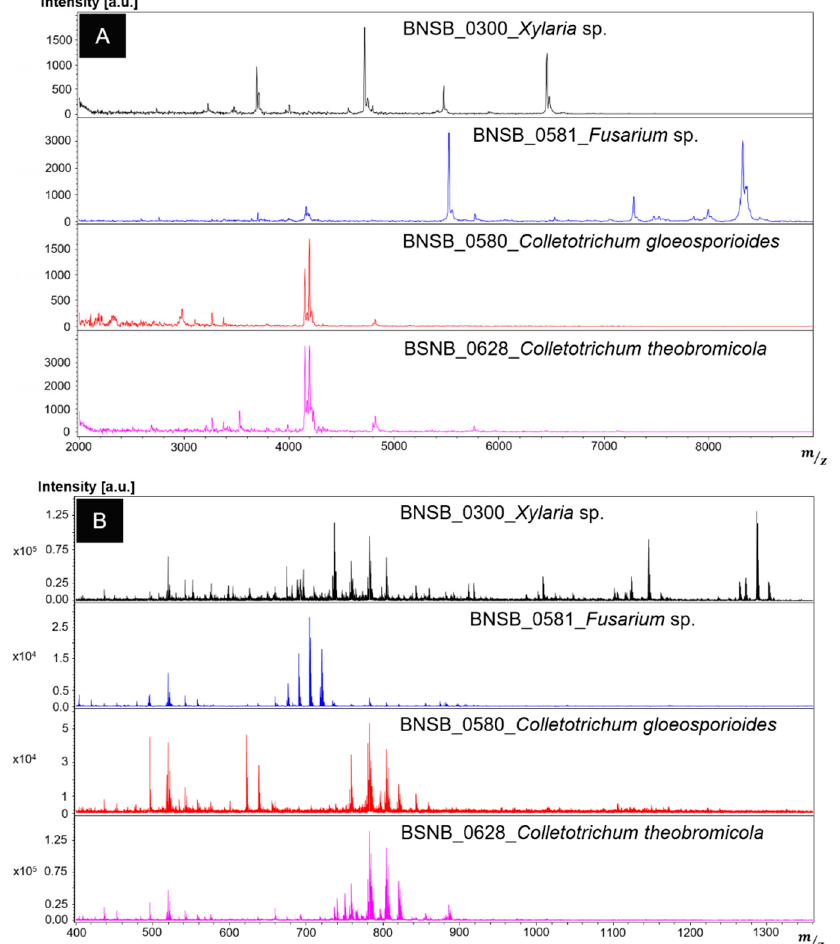
Figure 1. Examples of fungal protein fingerprints ( A ) and fungal lipid fingerprints ( B ) from BNSB. This method led to the data aggregation into twelve clusters (Figure 2). First clusters, named A and B, are composed of Enterobacterales in which are present the genera Proteus , Serratia , Yersinia (61 fingerprints—49.2% of Enterobacterales), and Citrobacter , Enterobacter , Escherichia , Klebsiella , Proteus , Salmonella , Serratia , and Shigella (46 fingerprints—37.1% of Enterobacterales), respectively. Genera not present in clusters A and B are Edwardsiella , Enterococcus , and Vibrio which are dispersed to the north of the network or are isolated nodes (15 fingerprints—12.1% of Enterobacterales). Cluster C (Figure 2) is only composed of the genus Brucella belonging to the order Rhizobiales (28 fingerprints—87.5% of Rhizobiales). The last genus of this order, i.e., Ochrobactrum , is located south of cluster C (4 fingerprints— 12.5%). Then, cluster D (in pink, Figure 2) includes the majority of Thiotrichales, of which only the genus Francisella is represented (20 fingerprints—83.3% of Thiotrichales). Fingerprints corresponding to the species Francisella guangzhouensis are at the opposite of cluster D (4 fingerprints—16.7%). Afterwards, clusters E, F, G, H, I, J (Figure 2) are composed of Burkholderiales. Among them, the genus Burkholderia is present only in clusters F, G, H, I, and in their periphery (134 fingerprints—80.7% of Burkholderiales). Clusters E and J includes species of the genera Pandoraea and Ralstonia , respectively (24 fingerprints—14.5%). The last nodes with fingerprints from Burkholderiales are scattered in the network; east (8 fingerprints—4.8% of Burkholderiales). Finally, clusters K and L (Figure 2) are solely composed of fingerprints from isolates belonging to the genus Bacillus (91 fingerprints— 53.8% of Bacillales). The last fingerprints from Bacillales are distributed in the center of